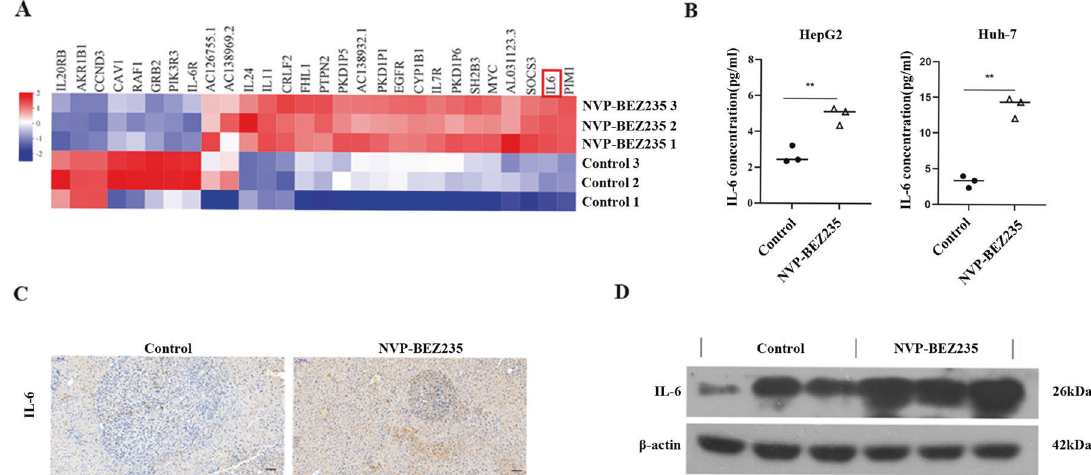
Fig. 3 NVP-BEZ235 increases the expression of IL-6. A RNA-seq-derived transcript analysis of NVP-BEZ235-induced genes in HepG2 cells. There was at least a two-fold up- or downregulation in the gene ( P < 0.01). Red indicates higher expression, and blue indicates lower expression. B IL-6 protein levels in HCC cells measured by ELISA. ** p < 0.01. C Representative images of IL-6 immunohistochemical staining in the control group and NVP-BEZ235-treated group from mouse liver tumour tissues. 100×; scale bar, 100 μ m. D IL ‐ 6 protein expression in the control group and NVP-BEZ235-treated group by western blotting of mouse liver tumour